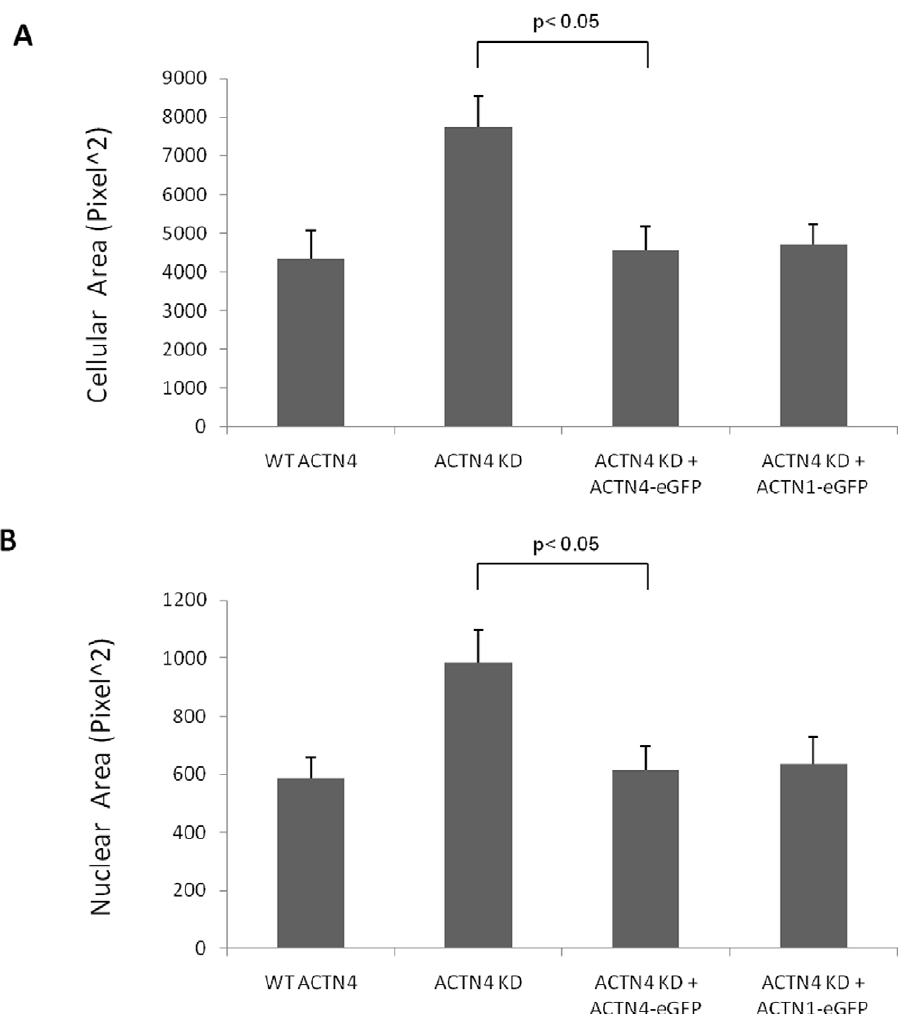
Figure 4. Knockdown of ACTN4 increases both cellular and nuclear cross-sectional area of murine lung fibroblasts. Murine lung fibroblasts of WT ACTN4 and ACTN4 KD transiently expressed eGFP and ACTN4 KD transiently expressed ACTN4-eGFP or ACTN1-eGFP were trypsined and then plated in 6-well Petri-dish plates coated with 1 m g/ml fibronectin. After incubation for 16 hr, cells were further incubated with 10 m g/ml Hoechst 33342 for 10 min at 37 u C in 5% CO 2 incubator prior to fixation with 2% formaldehyde for 30 min at room temperature. After taking fluorescent images under microscope, the cellular cross-sectional area of attached cells with GFP fluorescence (A) and the nuclear cross-sectional area with blue fluorescence (B) were measured by using ImageJ software. Quantification represents the average cellular and nuclear cross-sectional area ( 6 the standard deviation) of at least 50 individual cells chosen randomly.